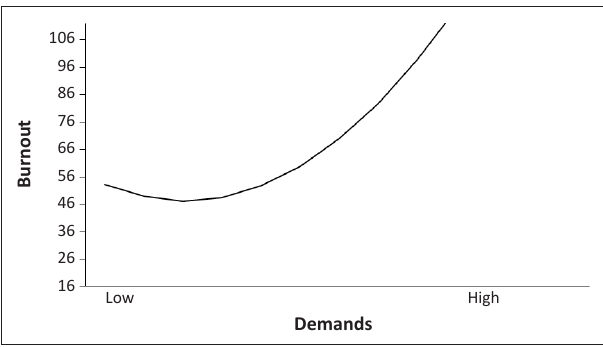
FIGURE 1: Curvilinear relationship between demands and burnout.